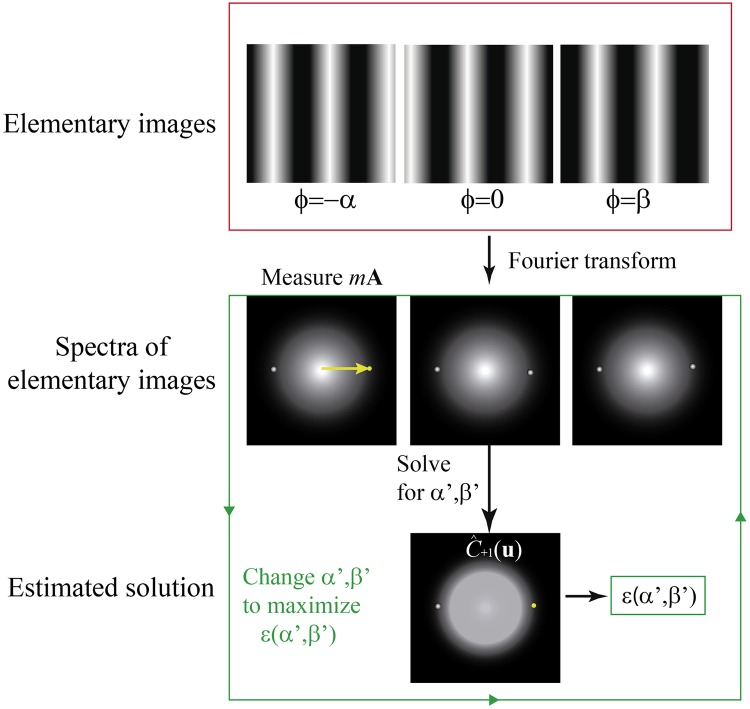
Algorithm scheme.Illustration of the normalized peak intensity difference procedure. The peak positions are measured from the Fourier transform of one elementary image. Then, the spectra of the elementary images are combined by solving the system of equations for estimated phase-shifts α′ and β′. The resulting solution represent an estimation SI components. The normalized peak intensity difference is measured and maximized through an iterative process.